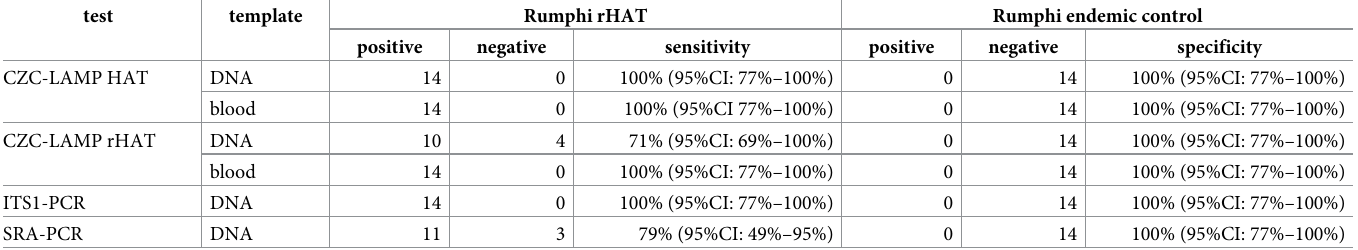
Table 2. CZC-LAMP HAT/rHAT test results using the blood-direct method using rHAT specimens from Rumphi, Malawi, and its comparison with results of the PCR tests.